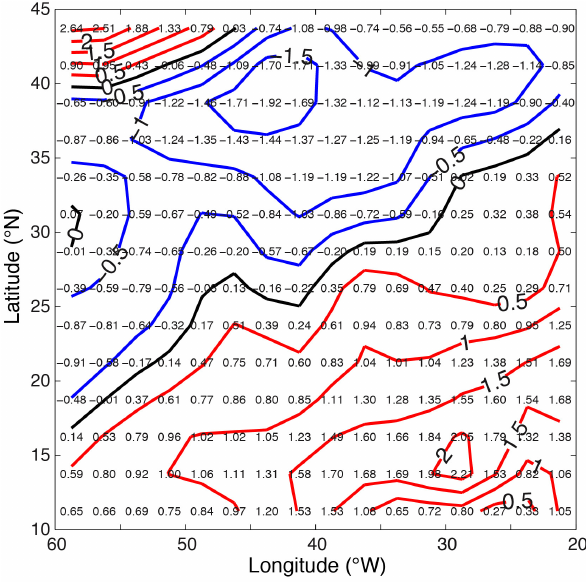
Figure 7. Temperature anomaly at 50m depth averaged for May– July 2010 at the end of the slowdown in the